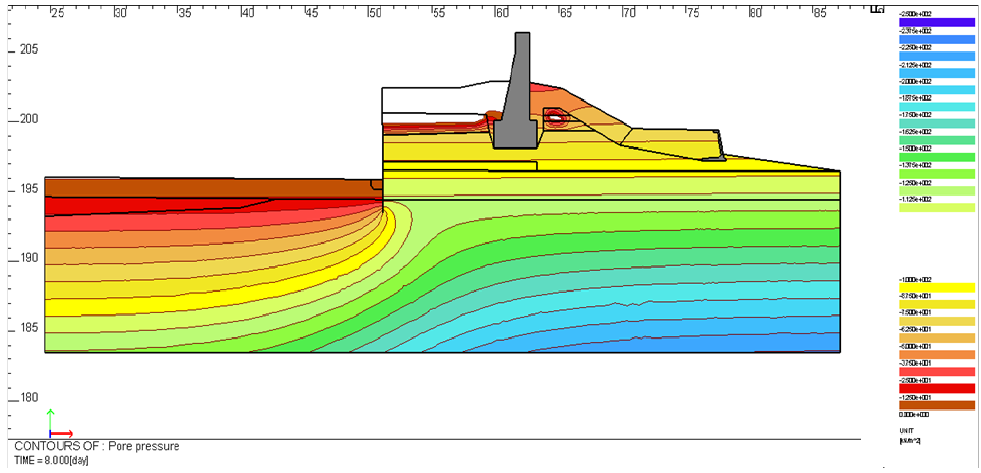
Figure 12: Pore pressure distribution, culmination of the flood, maximal depth of the excavation, no baseplate installed. Table 2: Most important material parameters used in analysis of deep excavation.